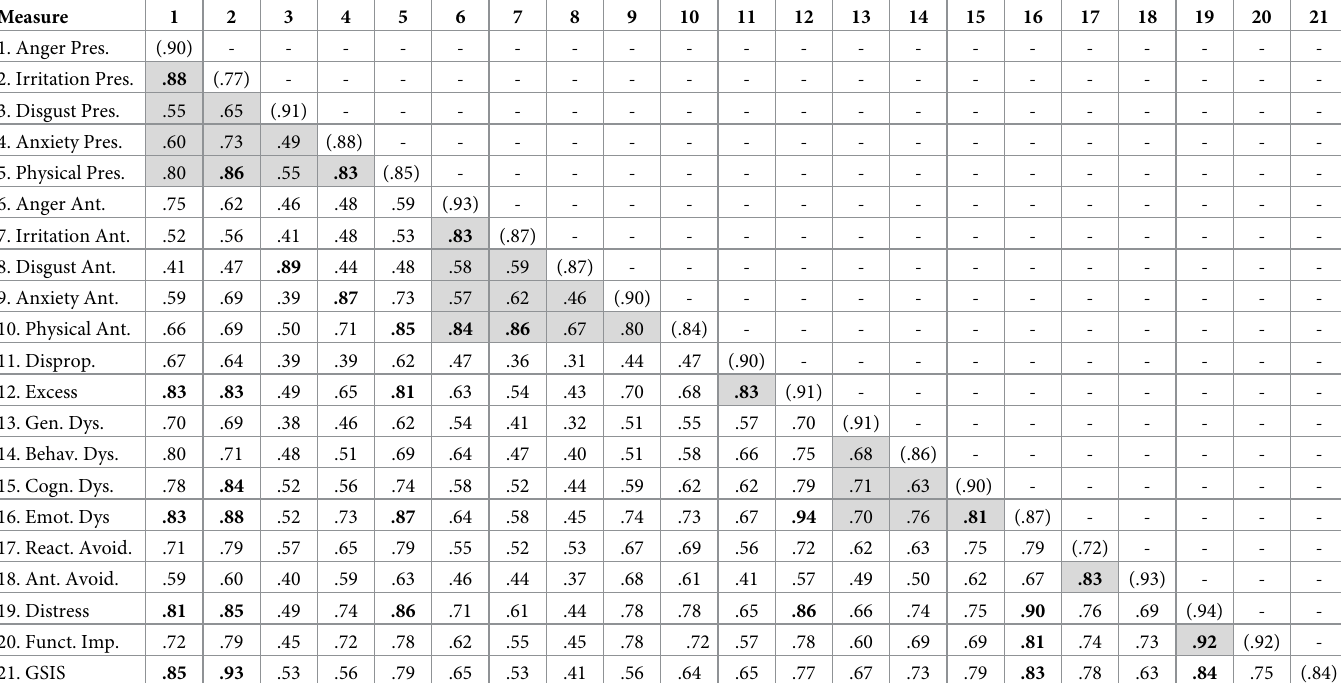
Table 4. Latent intercorrelations and reliability estimates for the BMQ-R symptom part and general sound intolerance